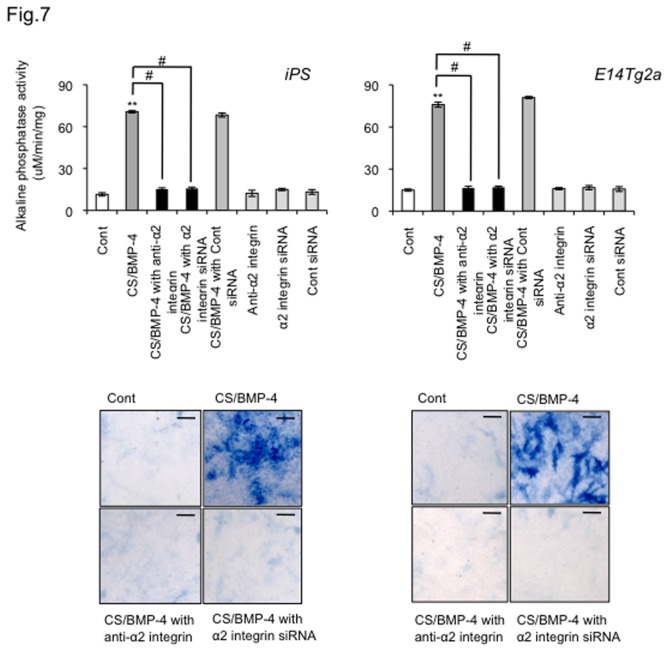
Effect of anti-integrin α2 mAb and siRNA on functional activity in odontoblast-like cells.Effect on ALP activity. CS/BMP-4-differentiated iPS cells and E14Tg2a cells were treated with either integrin α2-specific siRNA (or control siRNA) or anti-integrin α2 mAbs (or control mAbs). ALP activity data are presented as the mean ± SD (n=4) of the absorbance at 405 nm, normalized against total protein.